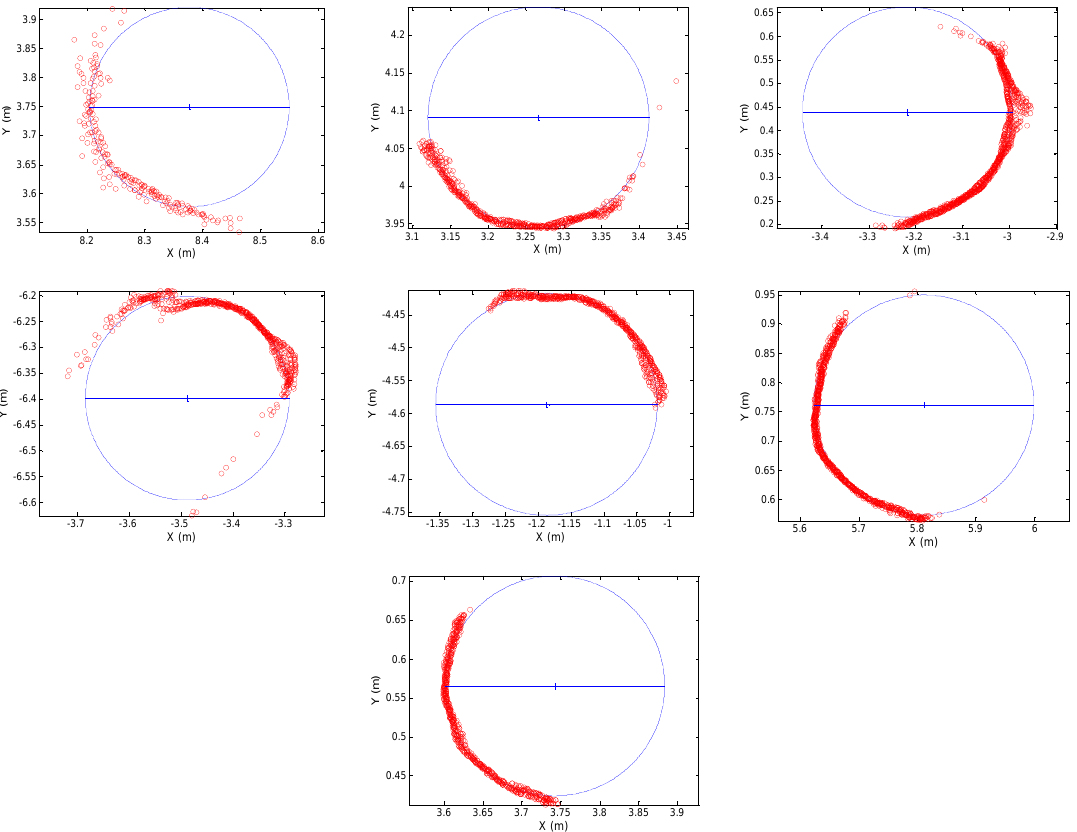
Figure 4. Circles fitted to the seven trunks to estimate the diameter at breast height (DBH) and position in the forest plot.